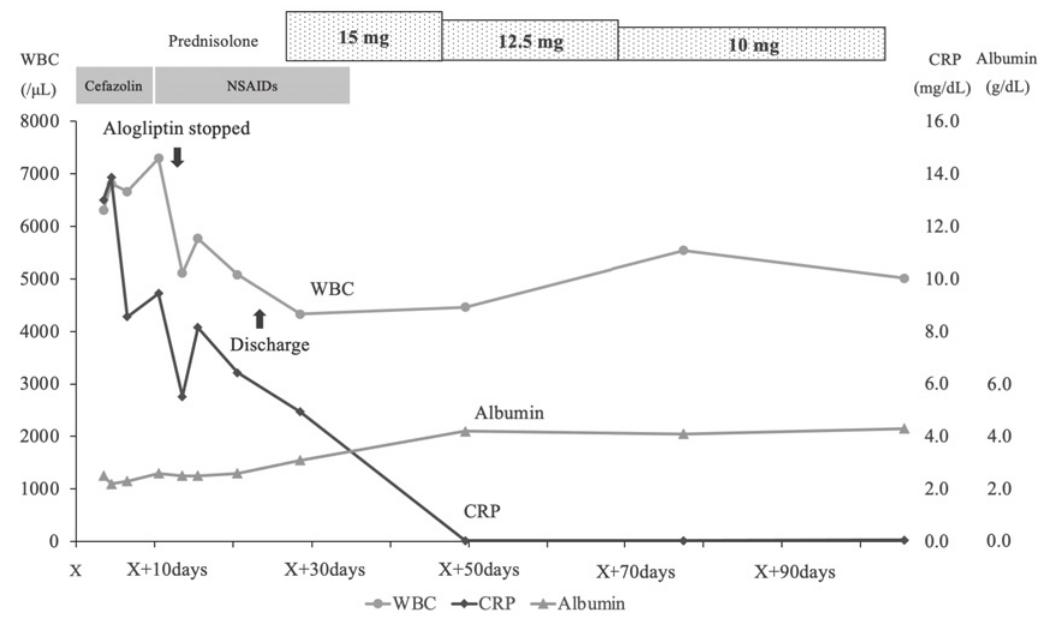
Figure 2. Clinical course. The circles indicate white blood cells, the squares indicate CRP, and the triangles indicate albumin. WBC, white blood cell; CRP, c-reactive protein; NSAIDs, non-steroidal anti-inflammatory drugs.